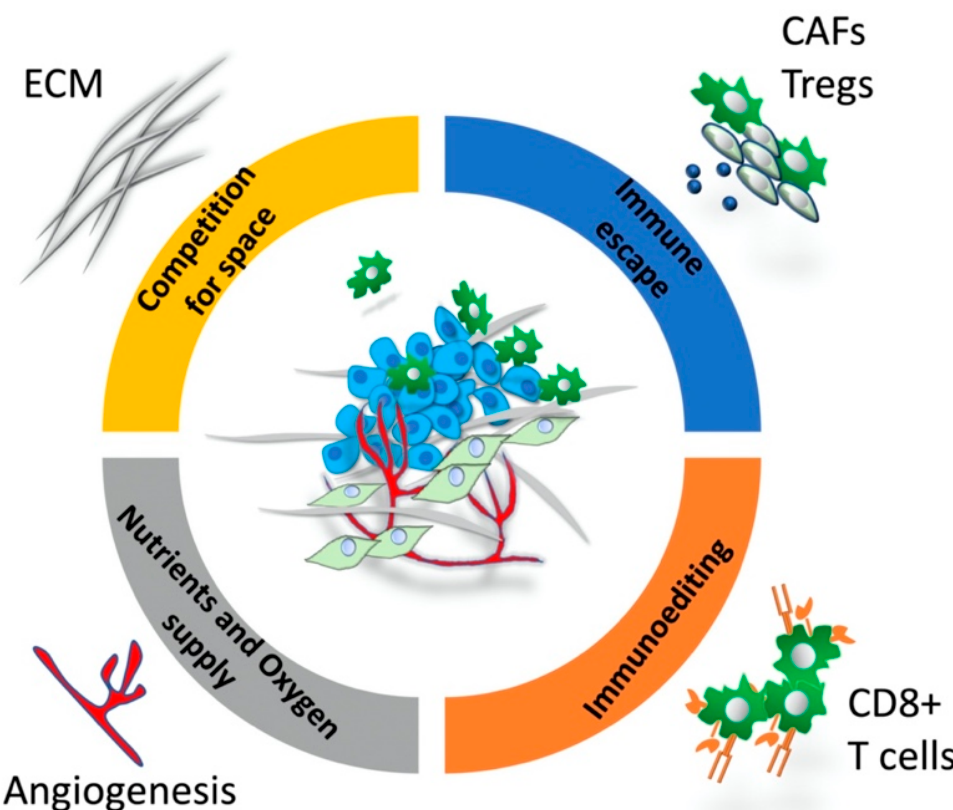
Figure 1. Tumor microenvironment and evolutionary pressures on cancer populations. ECM: extracellular matrix, CAFs: cancer-associated fibroblasts, Tregs: regulatory T cells, CD8+ T cells: cytotoxic T cells.